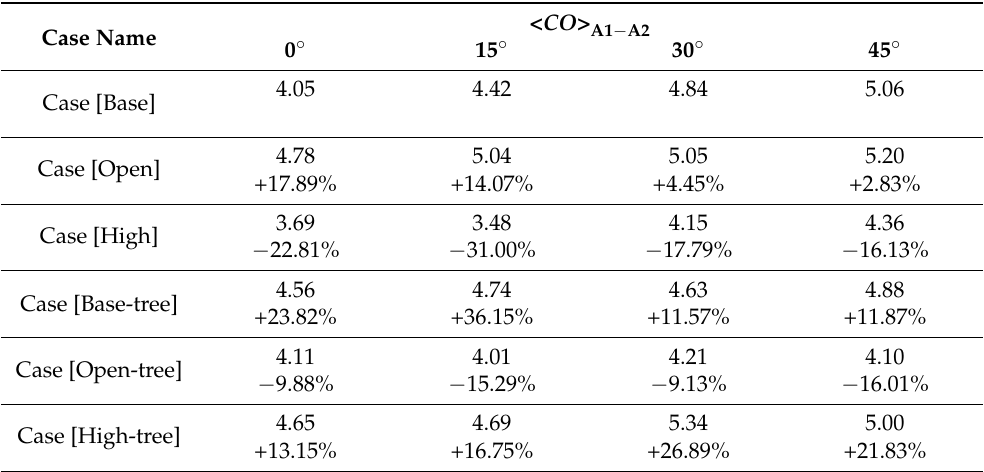
Table A9. Spatial mean CO concentration ( C ) at z = 2 m in the Region A1 − A2 (< CO > A1 − A2 ) of each scenario and the change